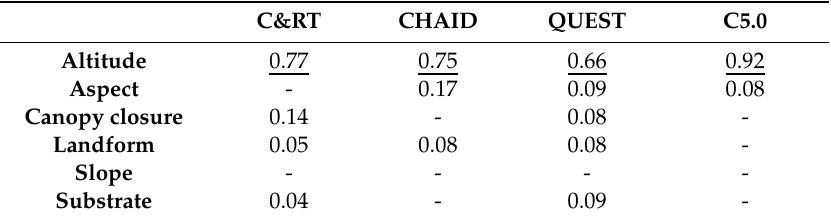
Table 2. Importance percentages of habitat parameters in predicting transplantation success by the decision tree algorithms (highest scores are underlined).